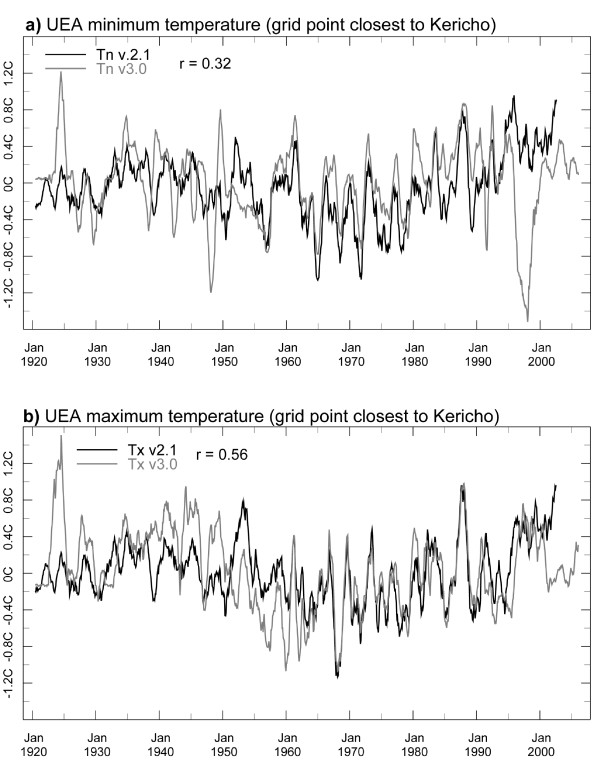
Time series (1920-2002) of Tn (a) and Tx (b) of the departures from the 1971-2000 average monthly values (an 11-month moving average applied) for versions 2.1 and interim 3.0 of the UEA CRU data and the gridpoint closest to the Kericho station location. The temporal correlation between the two series is shown in the upper-left of both panels.